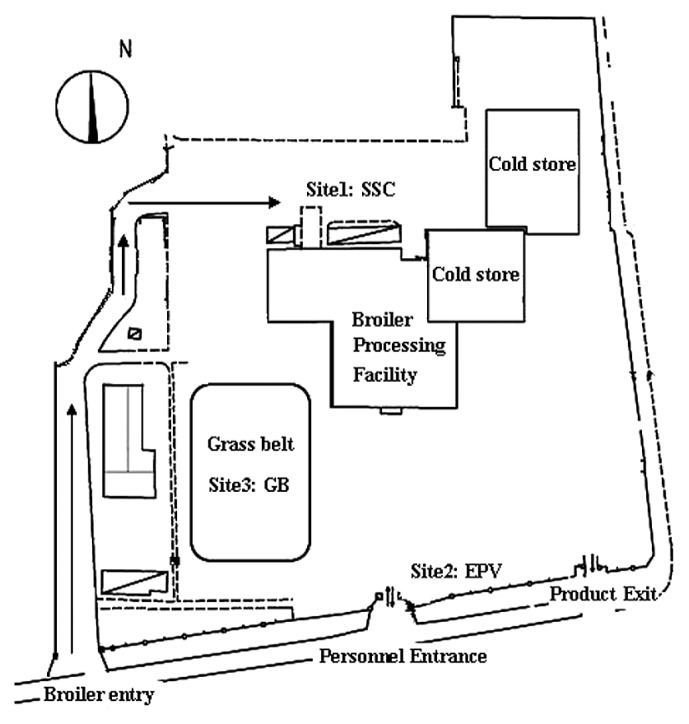
Map of the plant containing the sampling sites.